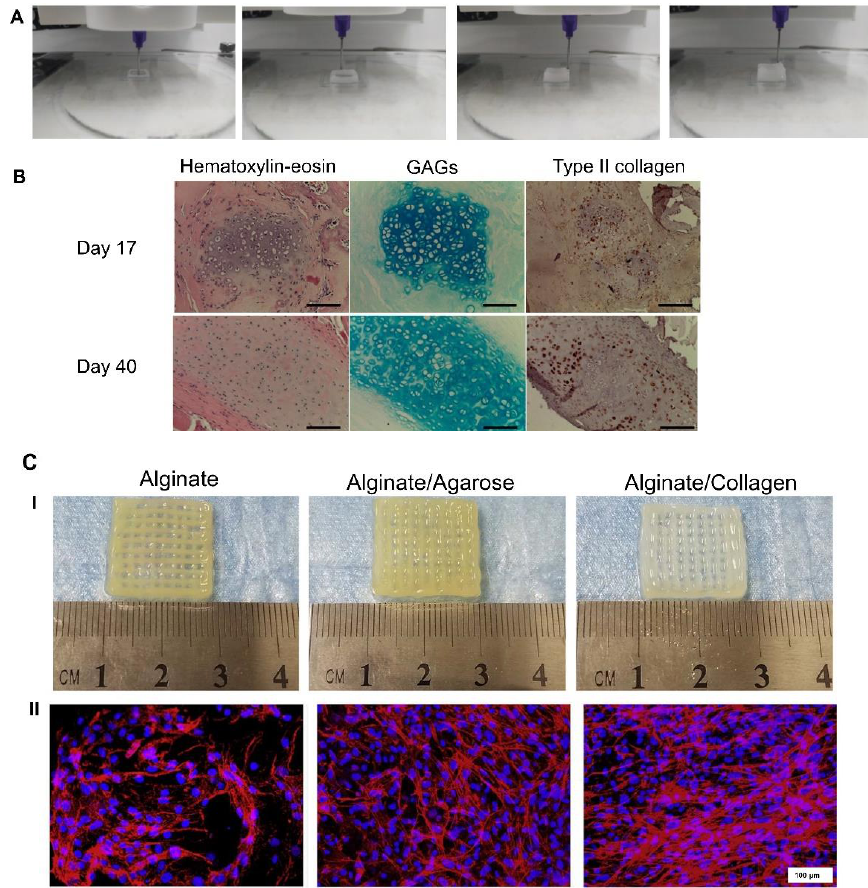
Figure 5. Collagen-based scaffolds: ( A ). Extrusion-based bioprinting of a 4% collagen scaffold. ( B ). Cartilage ECM evaluation after in vivo implantation. At day 40, GAG accumulation and type II collagen production were increased. Scale bar = 100 µ m. Adapted from [57]. ( C(I) ). Macroscopic images of alginate, alginate–agarose, and alginate–collagen scaffolds. ( C(II) ). Rhodamine–phalloidin/Hoechst 33,258 staining after 14 days of bioprinting. Scale bar = 100 µ m. Adapted from